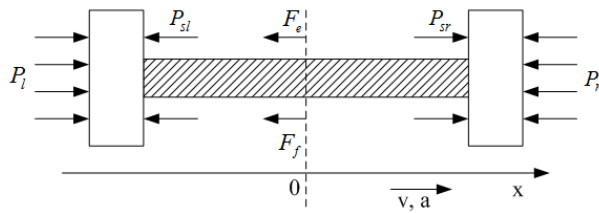
4 of 19 Figure 2. The numerical iterative method for FPGLG combustion process calculation. In Figure 2, x is the piston displacement; 𝑅 ℎ is the combustion heat release rate; 𝑃 and 𝑇 represent the in-cylinder gas pressure and temperature calculated by the CFD combustion model; 𝑃 0 and 𝑇 0 represent the in-cylinder gas pressure and temperature calculated by the CFD scavenging model. The detailed iterative process can be described as follows: 1.